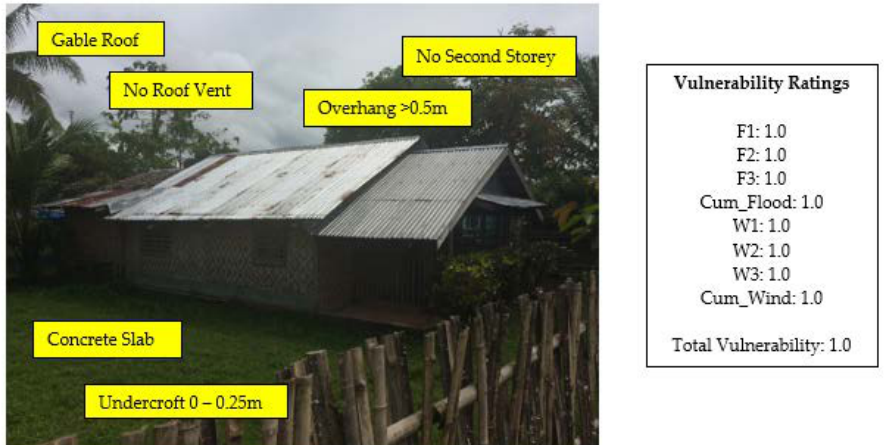
Figure 12. Example high vulnerability shelter from Badiangay.